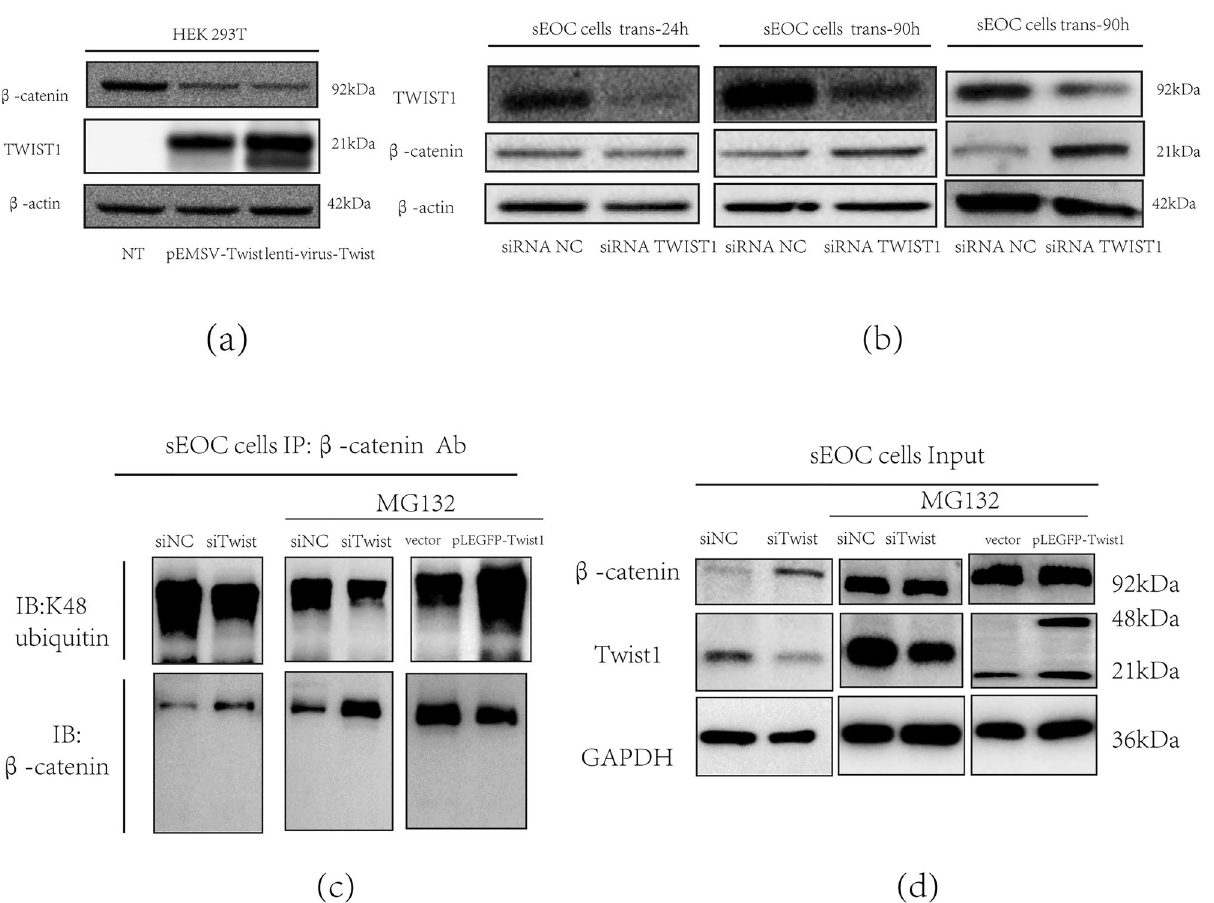
Figure 3. TWIST1 negatively regulates β-catenin by inducing its degradation. ( a )β-catenin expression after overexpression of TWIST1 in normal epithelial cells. ( b )β-catenin expression after TWIST1 knockdown in sEOC cells. ( c )After transfection with vector, pEGFP-Twist1 or siTwist1, β-catenin degradation was examined by Western blotting of sEOCs. ( d )After transfection with vector, pEGFP-Twist1 or siTwist1, β-catenin and TWIST1 were examined by Western blotting and sEOCs. Data are representative of three independent